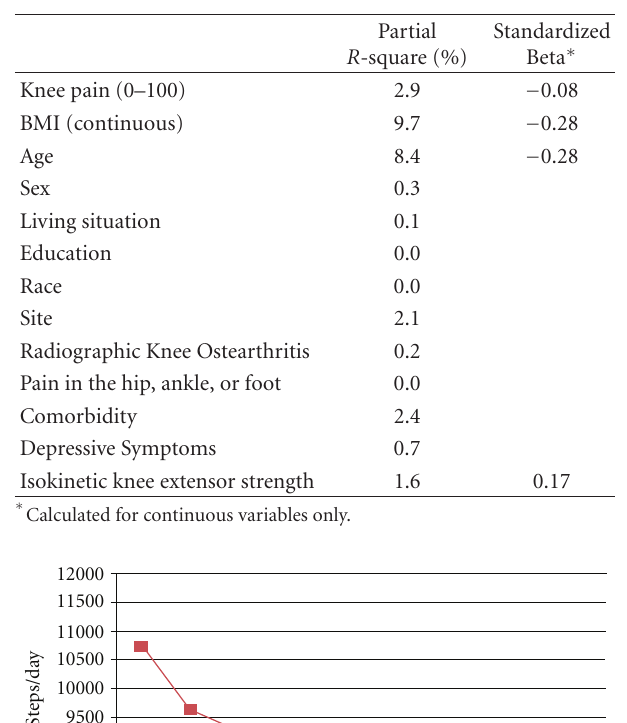
Table 3: Percentage of variability of walking attributed to pain, BMI, and covariates and expected change in walking for each one standard deviation increase in pain, BMI, and continuous